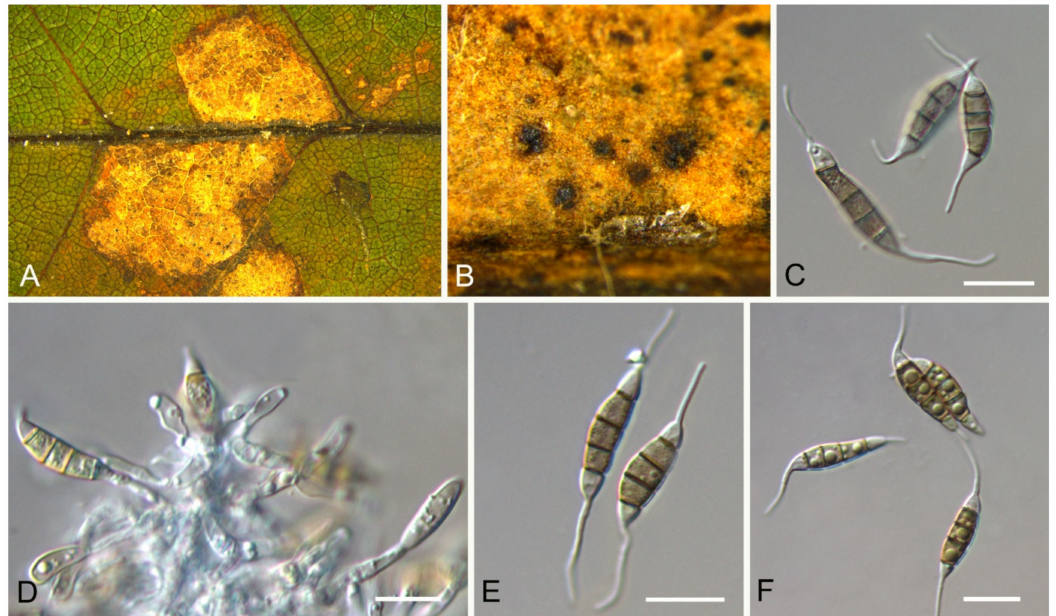
Figure 12. Monochaetia castaneae (BJFC-S1807). ( A , B ) Conidiomata on the diseased leaves of Castanea mollissima ; ( C , E , F ) Conidia; ( D ) Conidiogenous cells giving rise to conidia. Scale bars: ( C – F ) = 10 µ